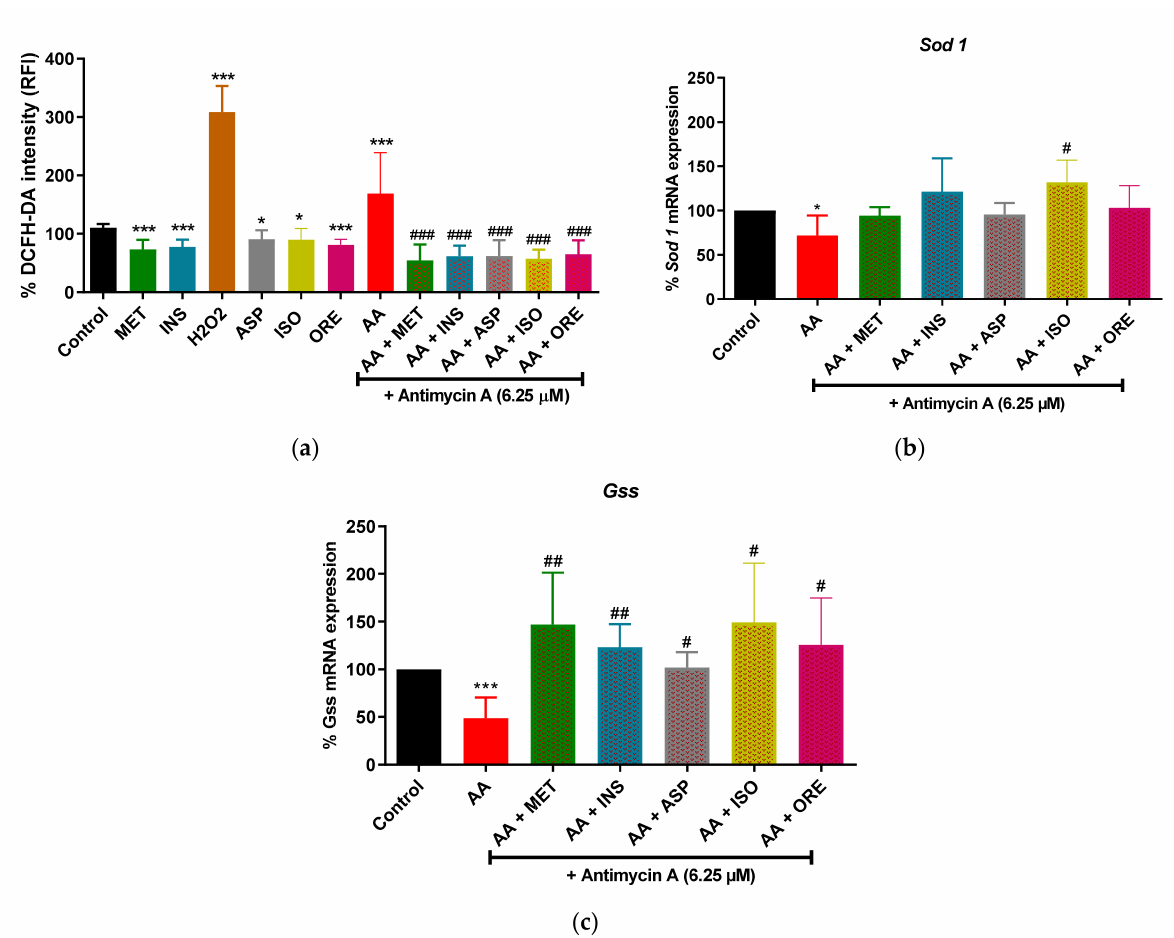
Figure 2. The impact of aspalathin, isoorientin, and orientin on the production of reactive oxygen species (ROS) ( a ) and the expression of antioxidants genes such as superoxide dismutase 1 ( Sod1 , ( b )) and glutathione synthetase ( Gss , ( c )) in cultured C2C12 myotubes following the exposure to antimycin A. Briefly, C2C12 cells were treated with antimycin A (6.25 µ M) for 12 h to induce mitochondrial dysfunction. Thereafter, cells were treated with aspalathin (Asp), isoorientin (Iso), orientin (Ore) (10 µ M), and comparative control metformin (Met) (1 µ M) for 4 h. Insulin (Ins) (1 µ M) and H 2 O 2 (1000 µ M) (ROS positive control) were added for 30 min. Results are expressed as mean ± SD of three independent experiments. * p < 0.05, *** p < 0.001 versus normal control; # p < 0.05, ## p < 0.01, ### p < 0.001 versus antimycin A control. Dichlorofluoresceine-diacetate (DCFH-DA) green fluorescence stain (intensity) was used as a measurement of ROS